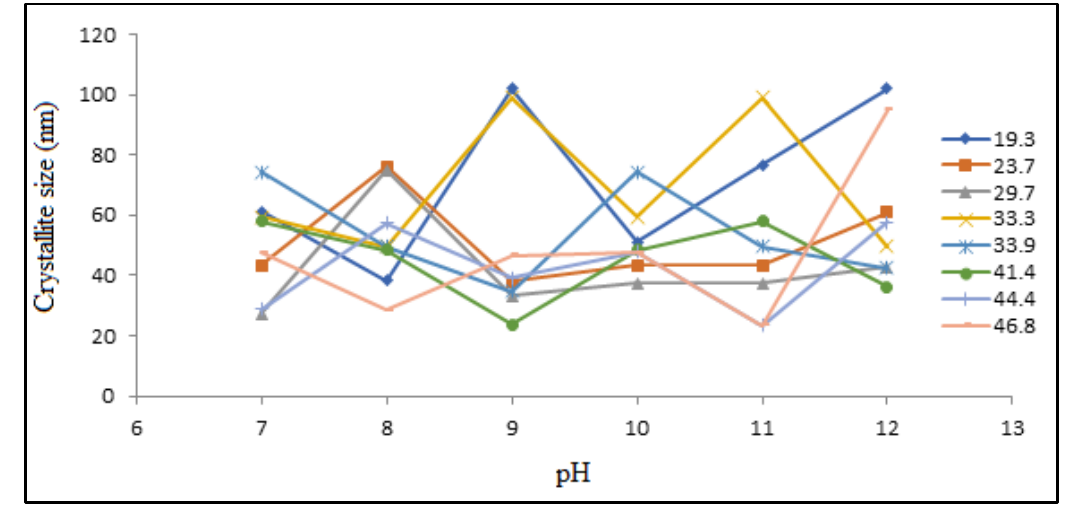
Figure 4. Crystallite size distribution for PPVA-AlPO 4 nanocomposites at different pH values (7–12).